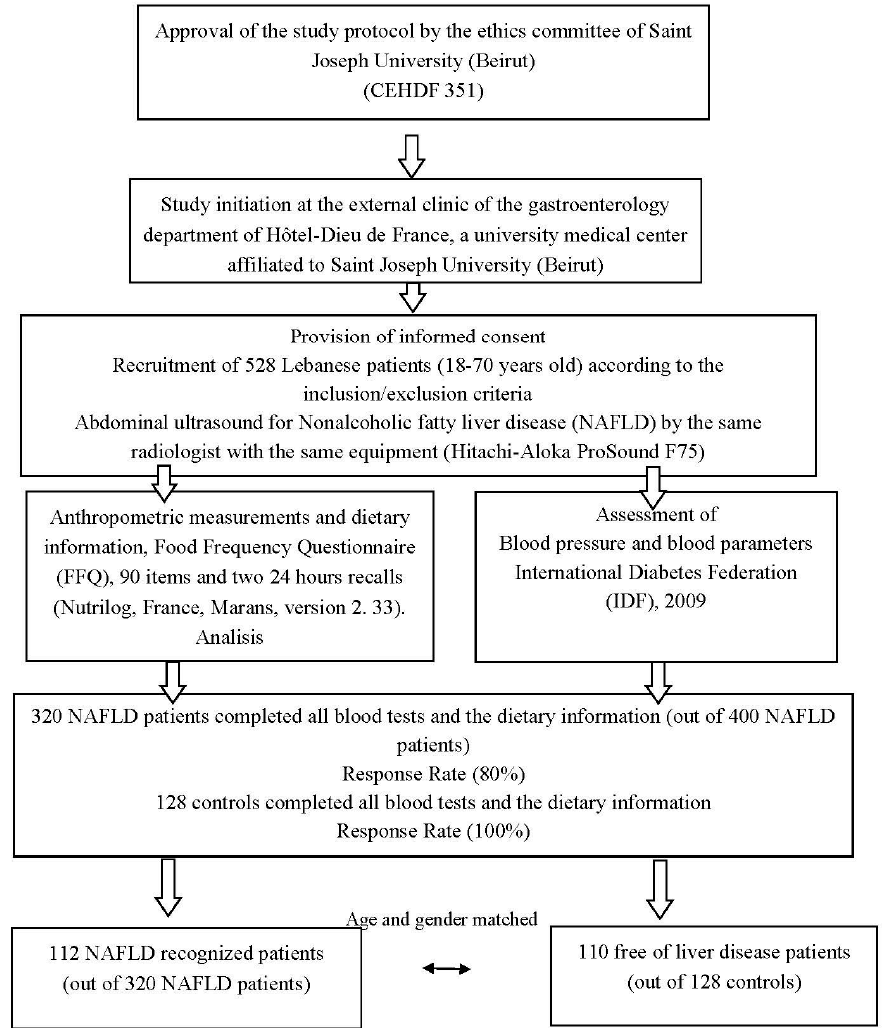
Figure 1. Flowchart for selection and enrollment of study subjects (cases and controls). NAFLD: Nonalcoholic fatty liver disease; FFQ: Food Frequency Questionnaire.